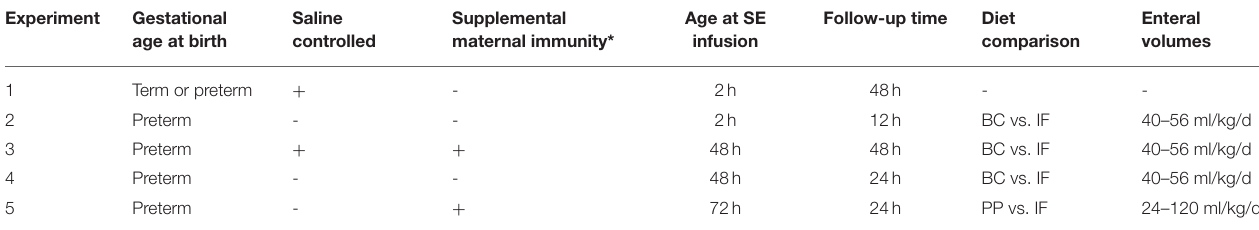
TABLE 1 | Overview of experiments.